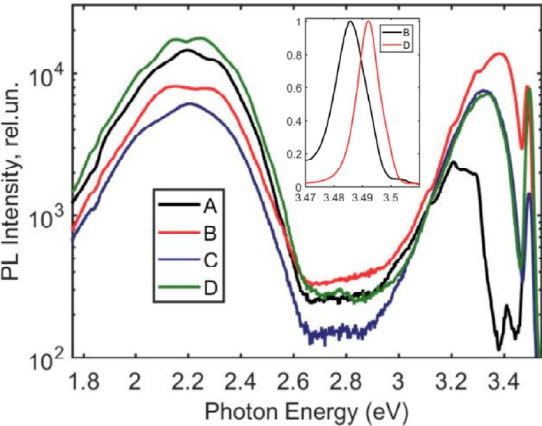
Fig. 9. Low-temperature photoluminescence spec- tra of the heterostructures. Insert show high resolu- tion exciton bands (see text for details).